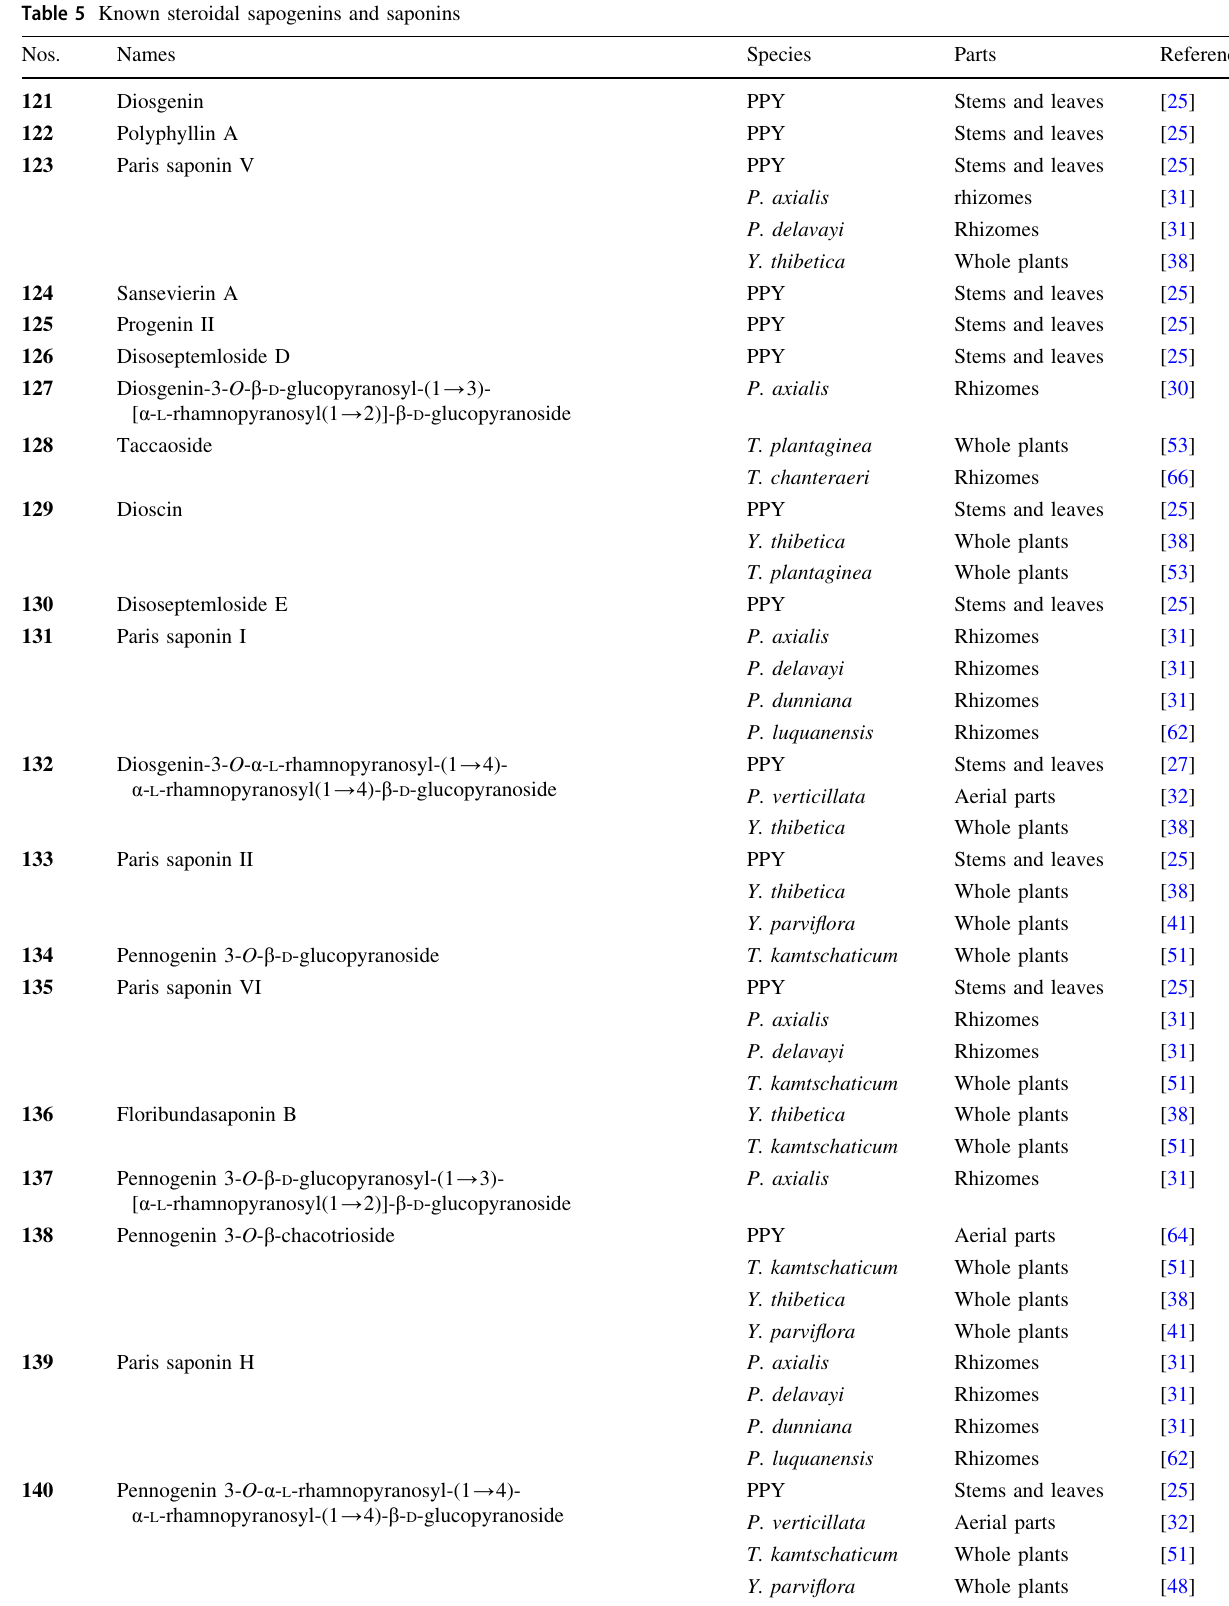
Table 5 Known steroidal sapogenins and saponins